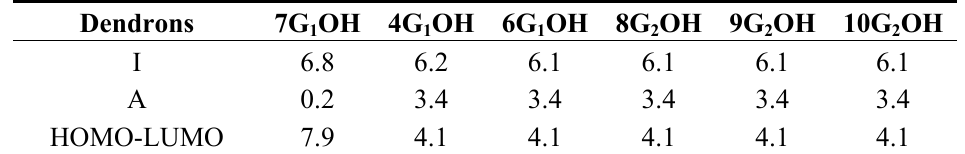
Table 3. Ionization energy (I), electron affinity (A) and the HOMO-LUMO gap in eV.